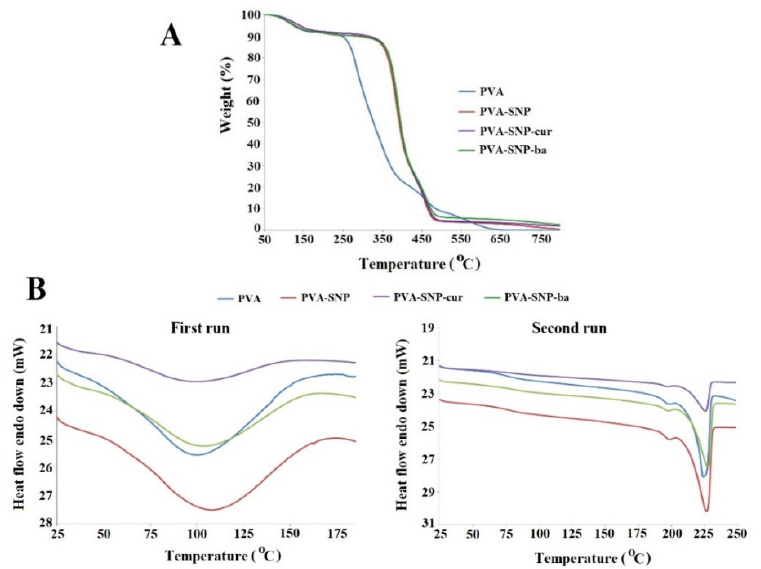
Figure 3. ( A ) TGA spectra of PVA, PVA-SNP, PVA-SNP-cur and PVA-SNP-ba.; ( B ) DSC curves of PVA, PVA-SNP, PVA-SNP-cur, PVA-SNP-ba.